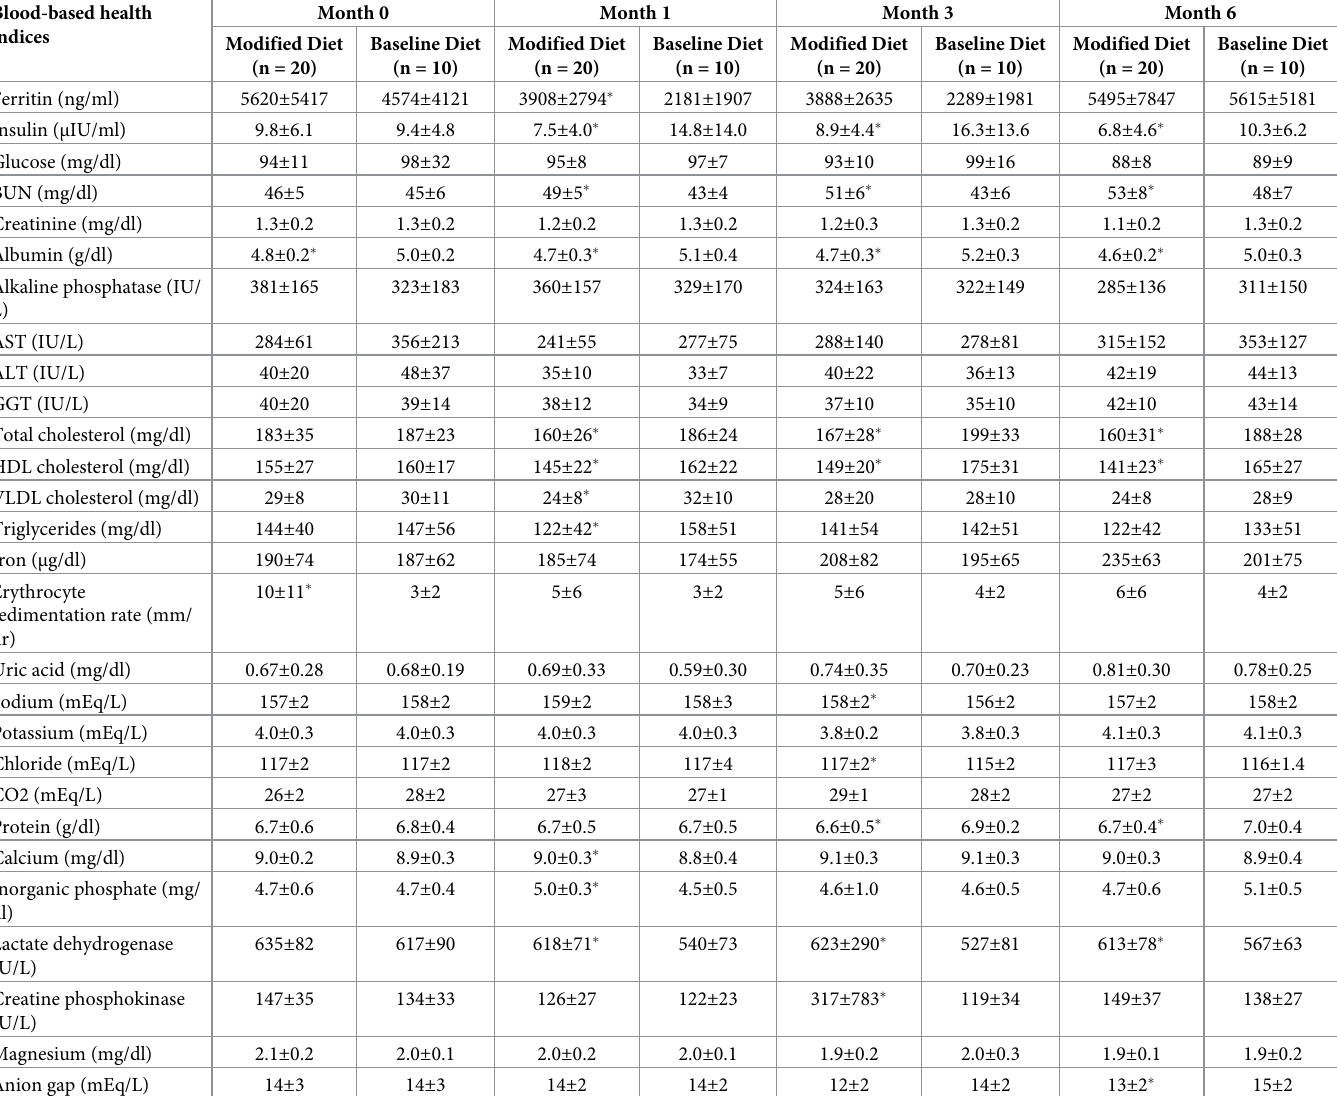
Table 2. Comparisons of clinical chemistry values in bottlenose dolphins ( Tursiops truncatus ) fed a modified versus baseline diet over 6 months. Blood-based health